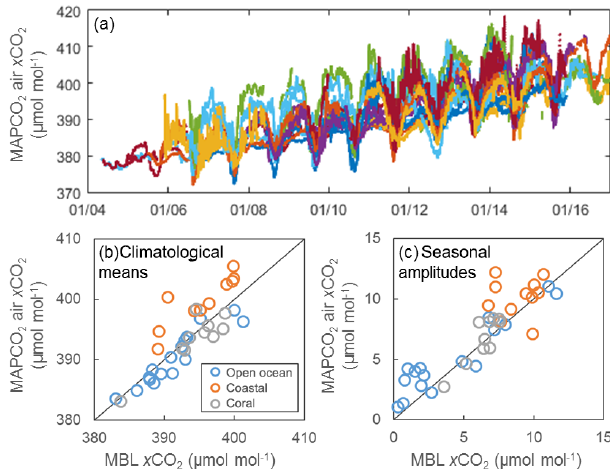
Figure 4. (a) Weekly averaged air x CO 2 observations from the 40 time series. Different colors represent different time series. Dates are MM/YY. (b) Climatological means and (c) seasonal ampli- tudes of air x CO 2 from the MAPCO 2 measurements compared to the GLOBALVIEW-CO2 MBL data product (GLOBALVIEW- CO2, 2013) for open ocean (blue), coastal (orange), and coral reef (gray) time series